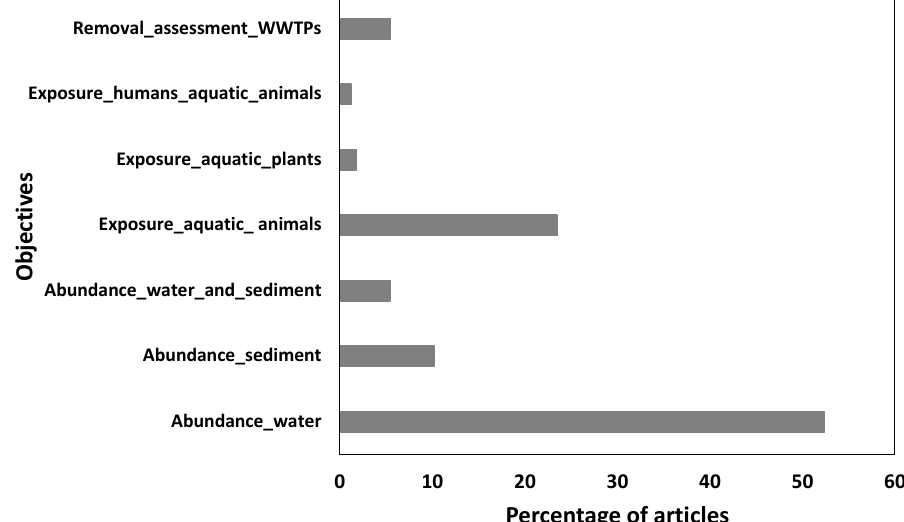
Figure 6. Classification of research articles based on the broad categories of the objective for the research work on MPs.